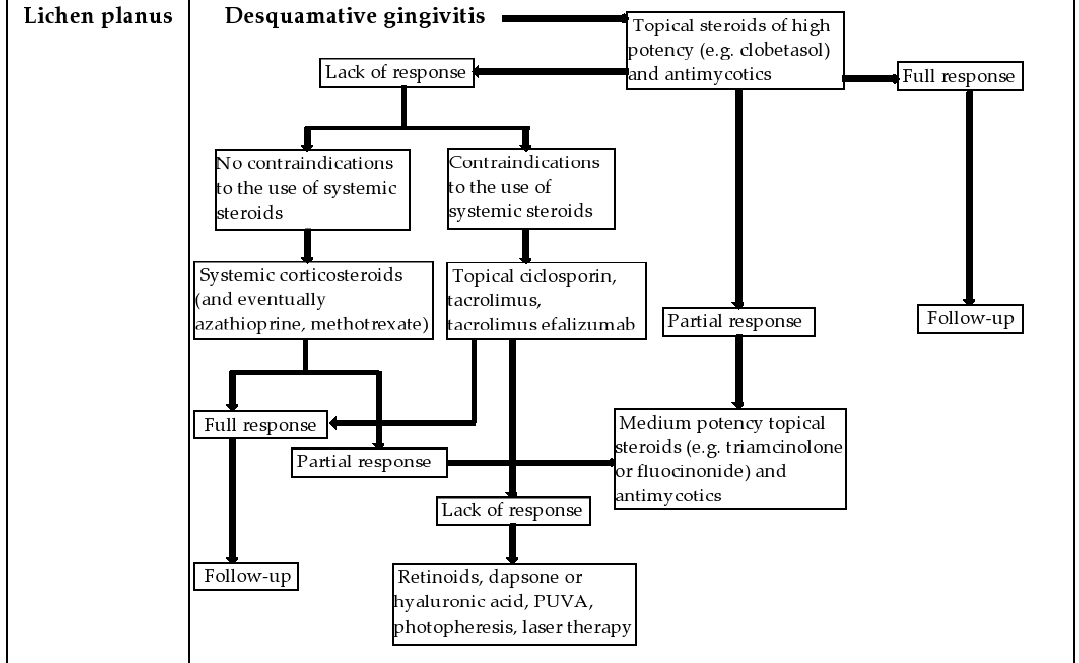
Figure 5. Treatment algorithm for desquamative gingivitis due to lichen planus. High-potency topical corticosteroids have been shown to be safe and effective for OLP lesions. In patients with atrophic-erosive form, a relatively equivalent efficacy of topical and systemic corticosteroid therapy was observed, demonstrating complete control of the disease in 68.2% of cases and 69.6%, respectively [50,86–88]. Local treatment with topical corticosteroids is initially recommended for symptomatic lesions, and in case of stationary or unfavorable evolution, systemic therapy may be considered. Limited lesions located on the fixed oral mucosa can be treated with ointments and creams